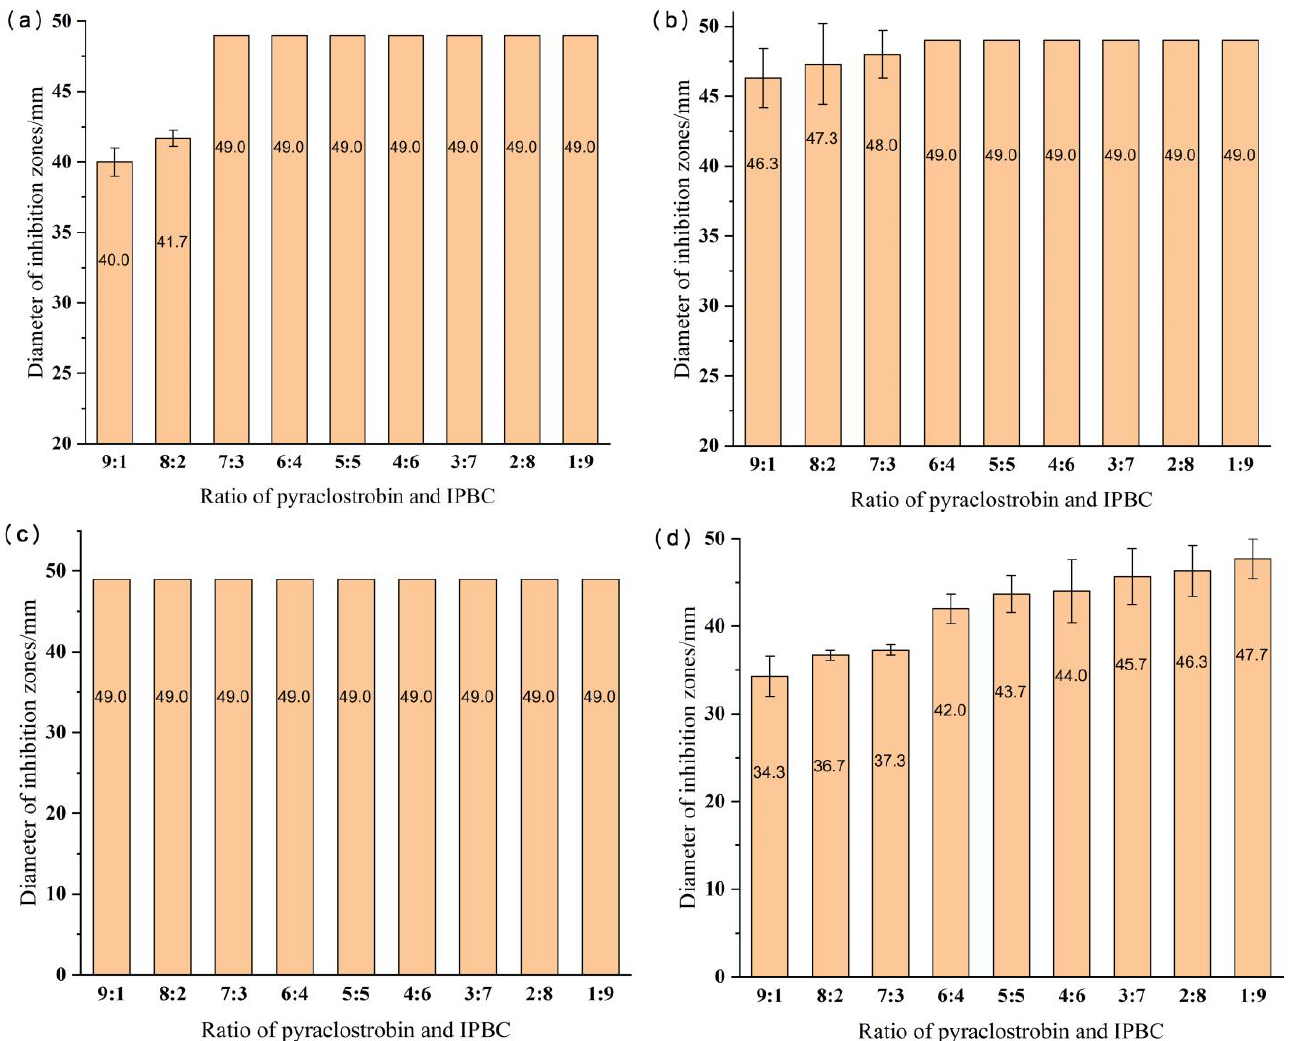
Figure 2. The diameter of the inhibition zone for different ratios of pyraclostrobin and IPBC at a concentration of 0.1%: ( a ) results for Botryodiplodia theobromae ; ( b ) results for Fusarium moniliforme ; ( c ) results for Alternaria alternate ; and ( d ) results for mixed mold strains.